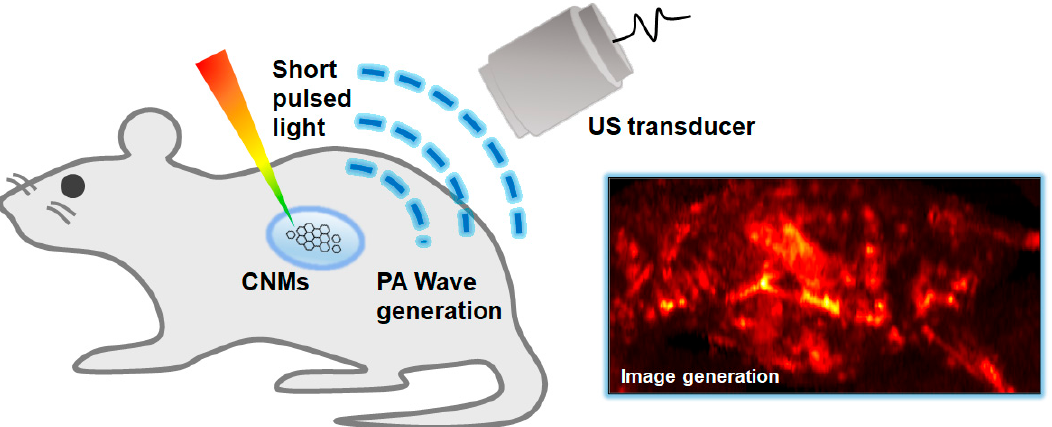
Figure 2. Schematic diagram of the principles of the PA imaging technique. PA, photoacoustic; US, ultrasound; CNMs, carbon nanomaterials.